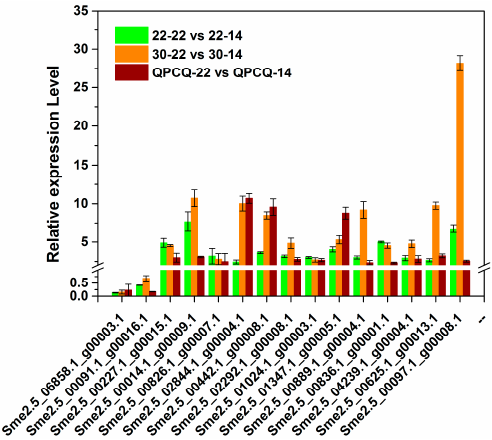
Figure 11. Verification of the expression of selected DEGs by qRT-PCR.